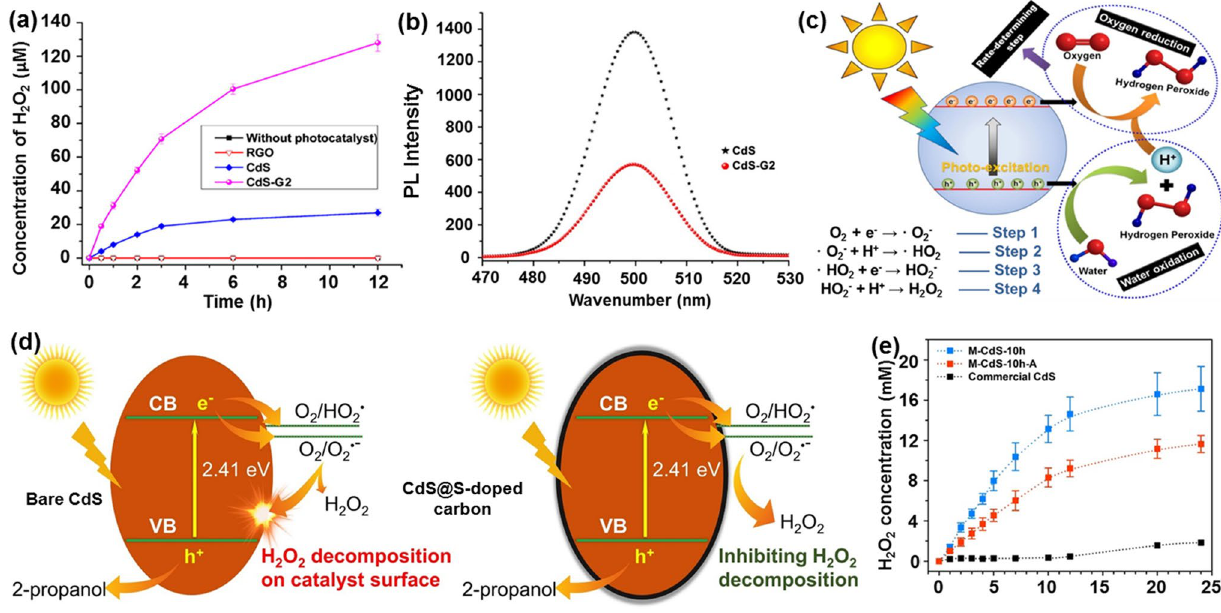
Fig. 10 a H 2 O 2 concentration produced on different catalysts. b PL spectra of the CdS and CdS-G2 photocatalysts. c Mechanism for H 2 O 2 pro- duction on the CdS-G hybrid photocatalyst under sunlight illumination. Reproduced with permission from Ref. [172]. Copyright 2016 Elsevier. Schematic illustration of H 2 O 2 formation over a CdS photocatalyst and a CdS@S-doped carbon photocatalyst. e H 2 O 2 concentration for 24 h with 20% of 2-propanol. Reproduced with permission from Ref. [174]. Copyright 2020